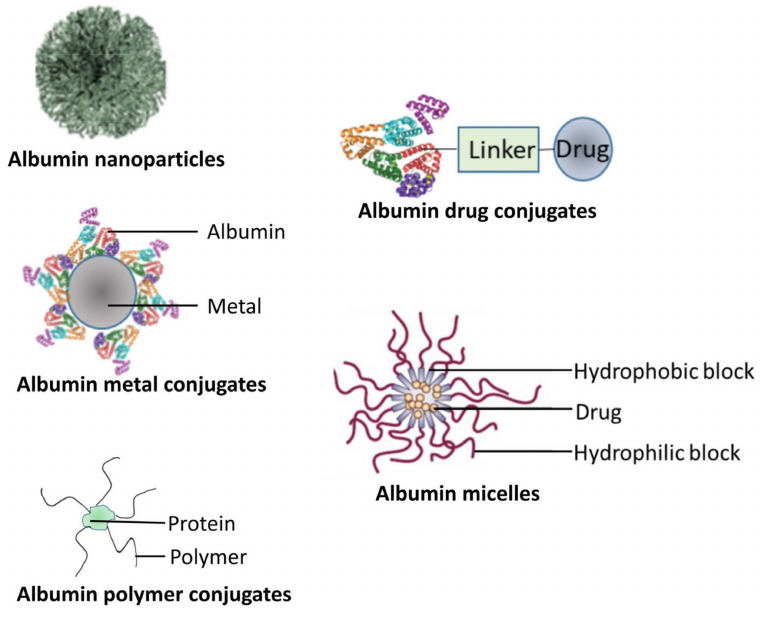
Figure 4. Different types of albumin-based